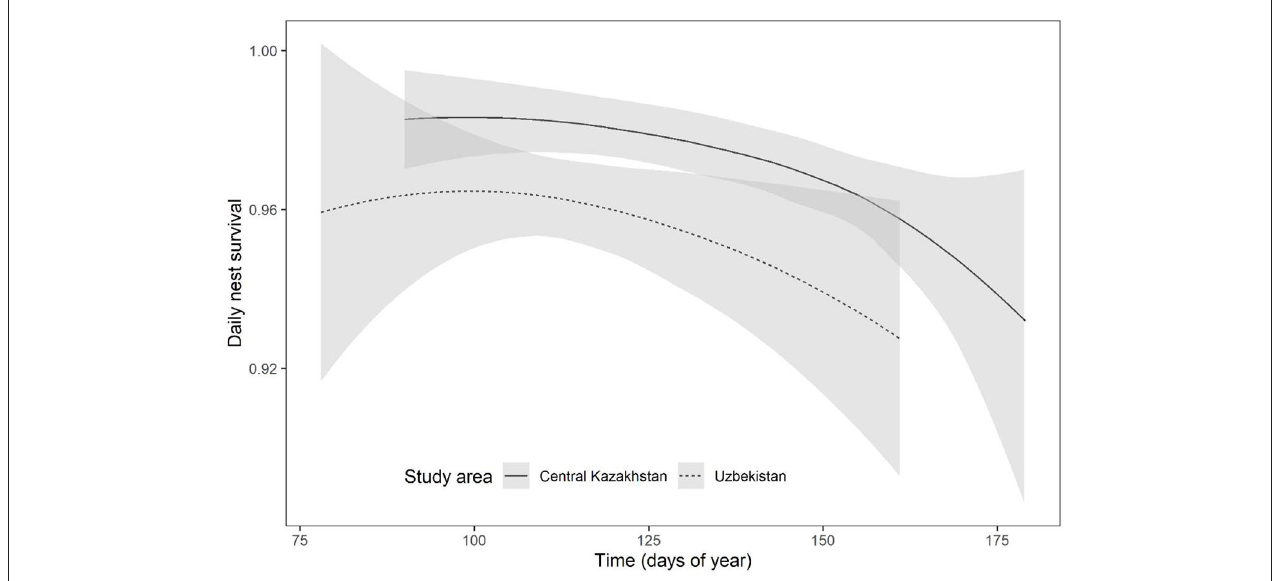
FIGURE 5 | Predictions of mean daily nest survival ( ± CI) for migrant Asian houbara ( Chlamydotis macqueenii ) nesting in central Kazakhstan and Uzbekistan with the progress of breeding